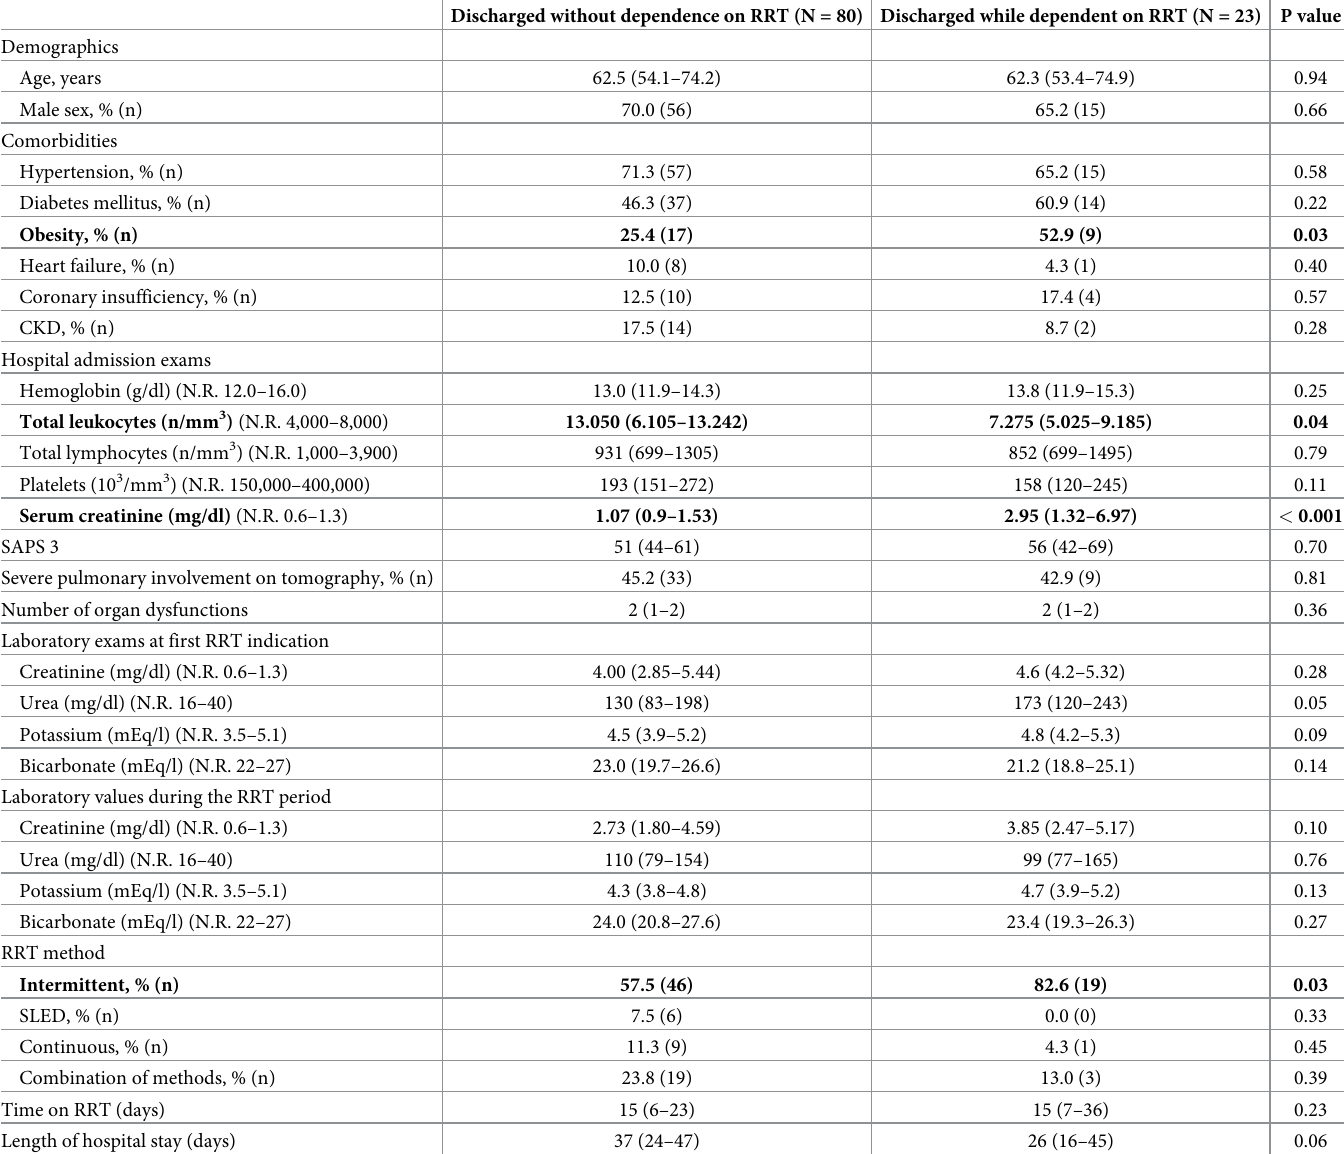
Table 4. Comparison between patients discharged while dependent and not dependent on kidney replacement